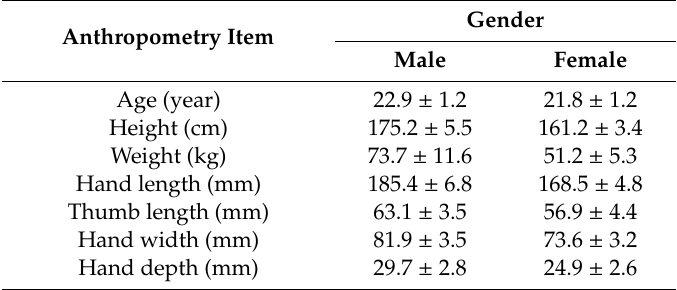
Table 1. Participants’ anthropometric data (Mean ± SD).